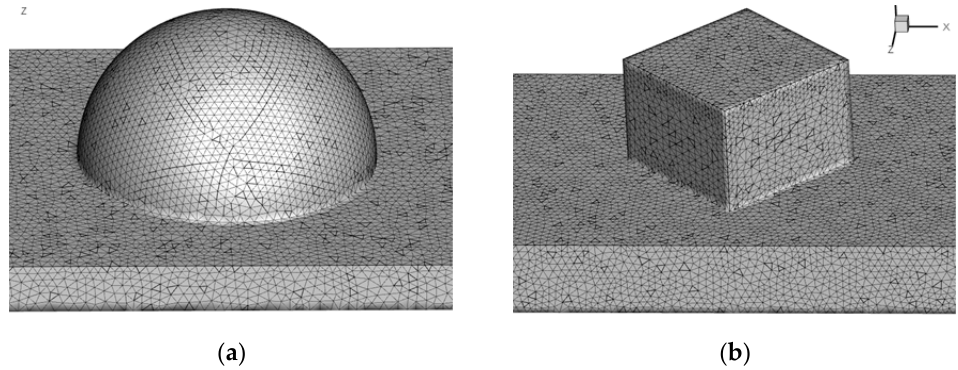
Figure 3. Grid structure of different dimples. ( a ) Hemispherical dimple. ( b ) Rhombus dimple. In order to capture the solution in viscous sub-layer near the wall, fine mesh is adopted for the near-wall region to satisfy (y + ≈ 1) at the adjacent wall of near-wall regions, which is applicable with enhanced wall treatment for the studied range of Reynolds num- bers. For capturing the boundary layer and satisfying the value of YPlus (y + ≈ 1), grid parameters are used for the axisymmetric model as follows: First layer thickness ( △ y 1 = 0.00215 mm), growth rate (GR = 1.02), and number of division( n = 120) as shown in Figure 4. Figure 4. Grid parameters.